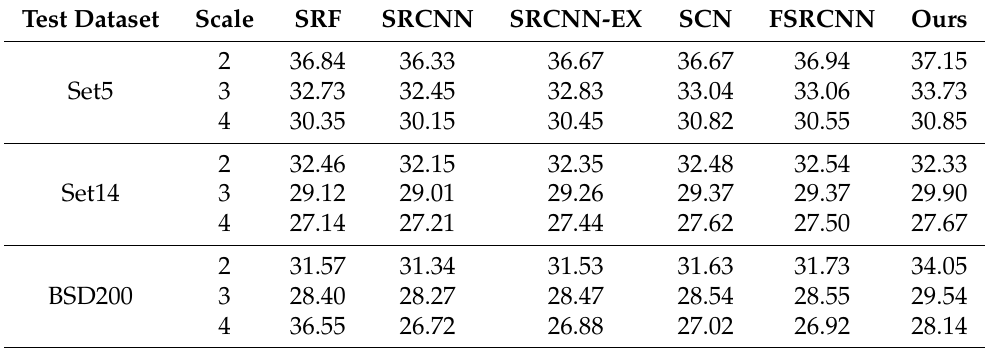
Table 2. The results of PSNR (dB) on three test datasets. All models are trained on the 91-image dataset.